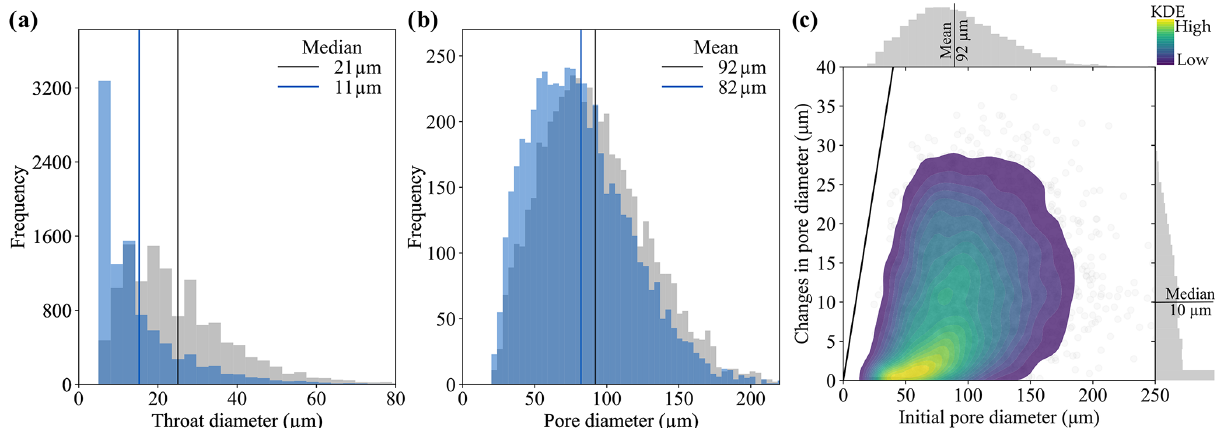
Figure 3. (a) Distribution of the throat and (b) pore diameters for transport-controlled precipitation (blue, (cid:56) = 17%) and the unaffected initial pore morphology (grey, (cid:56) = 23%). (c) Changes in pore diameters depending on the initial pore size for each